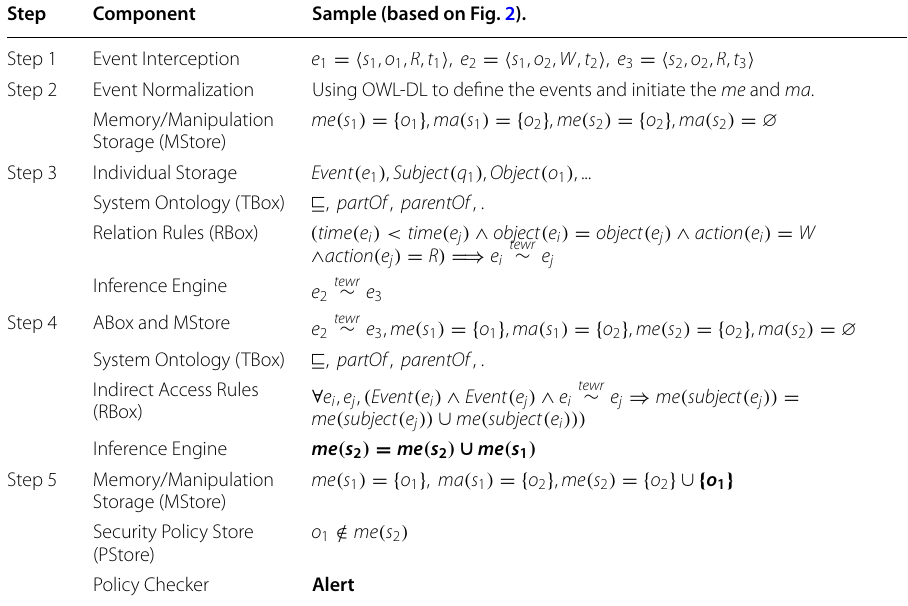
Table 2 Steps of policy violation detection for file removal example according to Figure 2 [16] Sample (based on Fig.